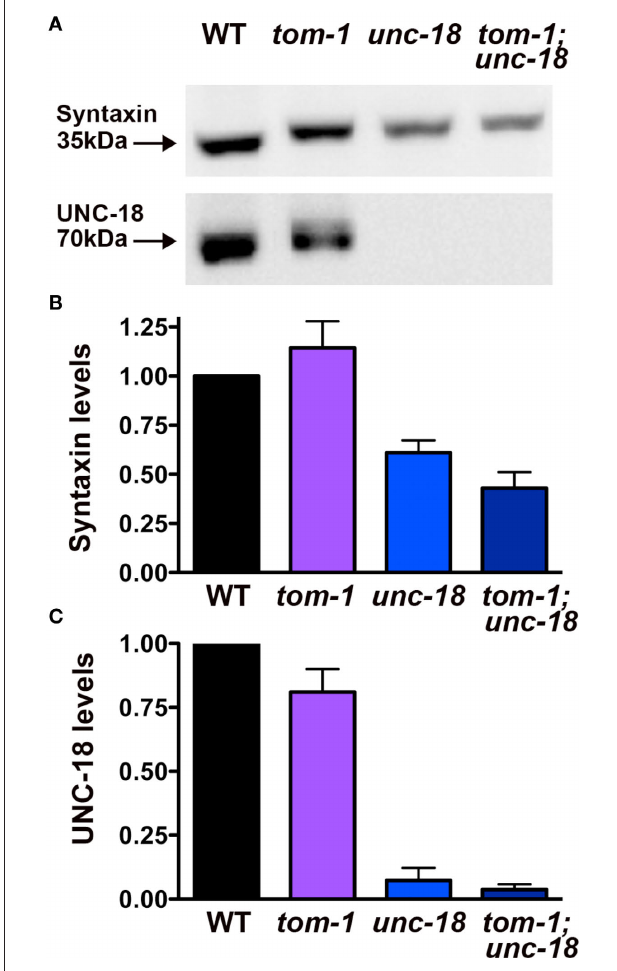
FigUre 8 | tom-1 mutants do not affect syntaxin levels in either wild-type or unc-18 mutant backgrounds. (A) Representative Western blots derived from 50 lysed larval stage four worms probed with antibodies against syntaxin (upper blot) or UNC-18 (lower blot). Lanes: (1) wild-type (2) tom-1(ok285) (3) unc-18(md299) (4) tom-1(ok285);unc-18(md299) . (B) Averaged syntaxin levels normalized to anti-tubulin immunostaining of stripped membranes ( n = 3 experiments). (C) Averaged UNC-18 levels normalized to anti-tubulin immunostaining of stripped membranes ( n = 3